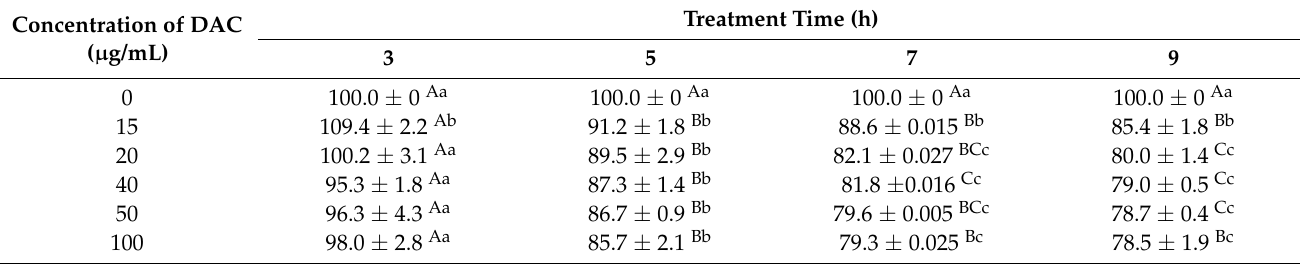
Table 10. The effect of DAC on relative content of ROS in GMEC